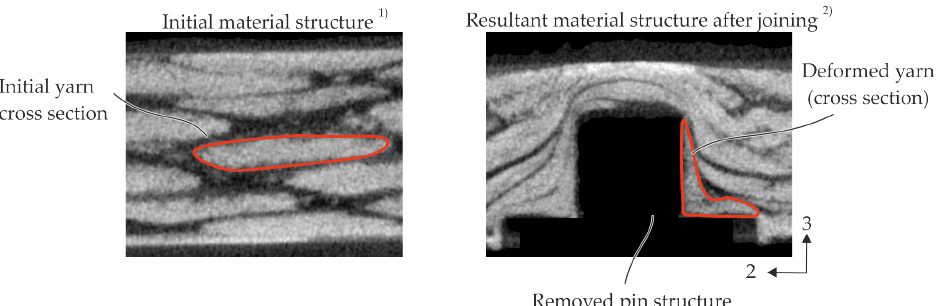
Figure 1. Computed tomography (CT) analysis of initial 1 ) and resultant material structure 2 ) of the pinning process of [4]. 1 ) —Different specimen area as resultant material structure; 2 ) —Pin structure is eliminated for more accurate CT